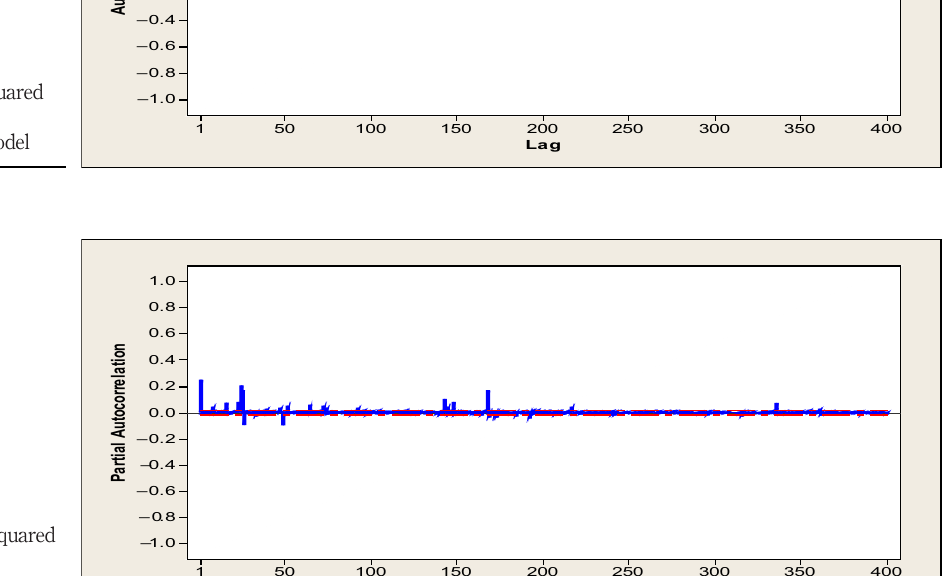
Figure 6. PACF of the squared residuals of DSARIMA